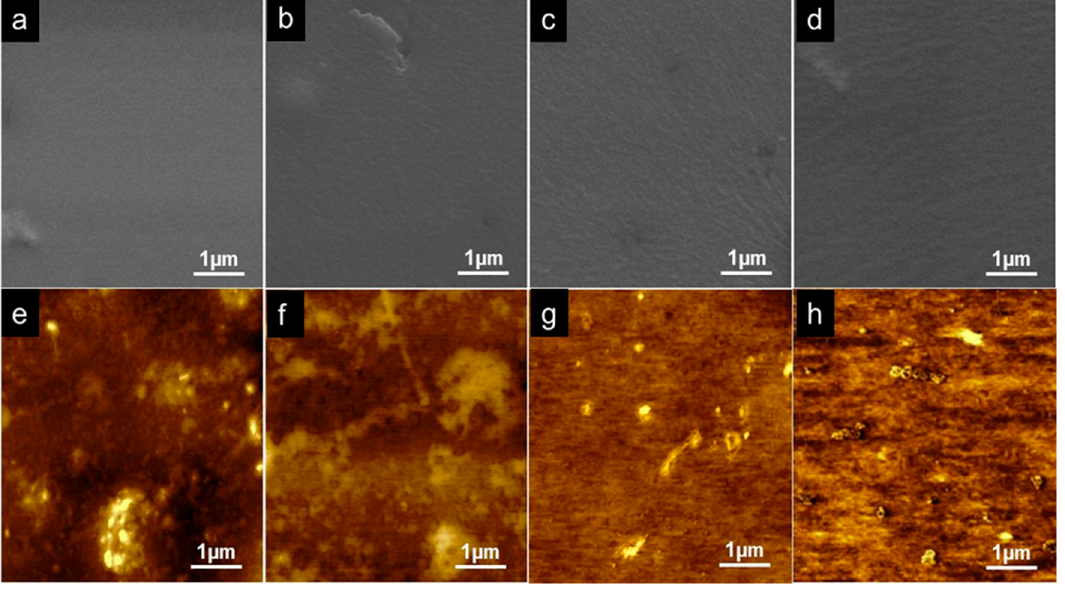
Figure 6. The surface SEM and AFM images of PAN/PAN- r -PEGMA composite membranes ( a , e ) PAN- r -PEGMA40; ( b , f ) PAN- r -PEGMA60; ( c , g ) PAN- r -PEGMA64, and ( d , h ) PAN- r -PEGMA67.